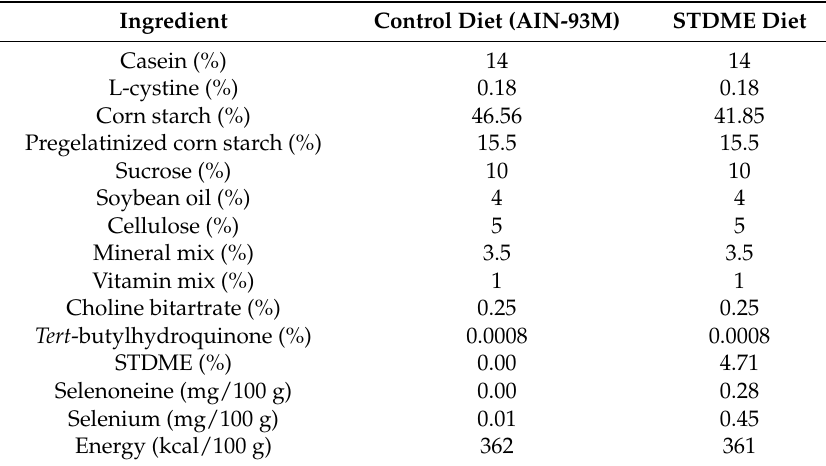
Table 2. Composition of experimental